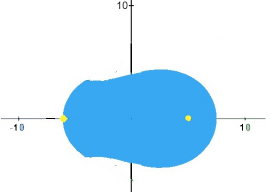
Figure 6: The colored area represents Γ ( F ) ∩ Γ ( F T ) ∩ Γ ( G ) ∩ Γ ( G T ) . The two points in yellow are the eigenvalues −6 and 5 of A 2